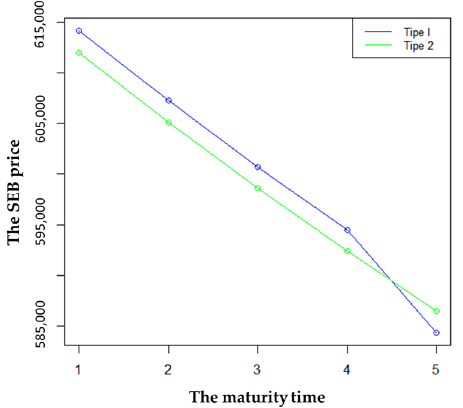
Figure 19. SEB Price based on seismic information in cluster types I and II with e = 0.05, PV = IDR 1,000,000, T = 1,2,3,4,5.